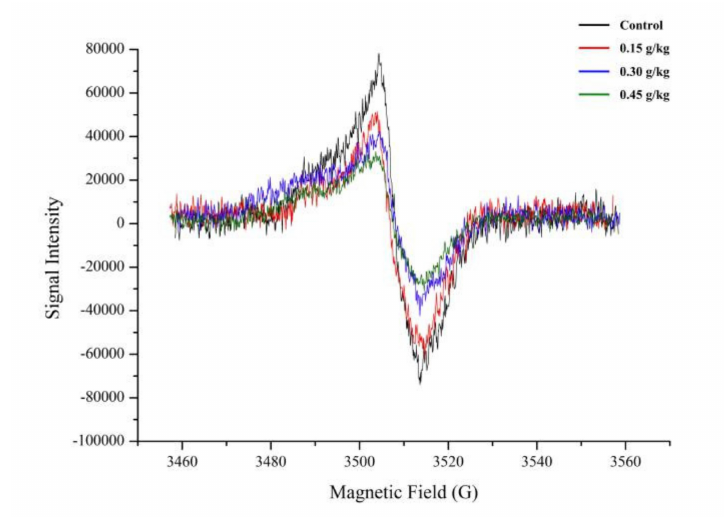
Figure 3. ESR spectra of roast lamb with the addition of different levels of TRE. Black curve: Control (without TRE); Red curve: 0.15 g/kg TRE; Blue curve: 0.30 g/kg TRE; Green curve: 0.45 g/kg